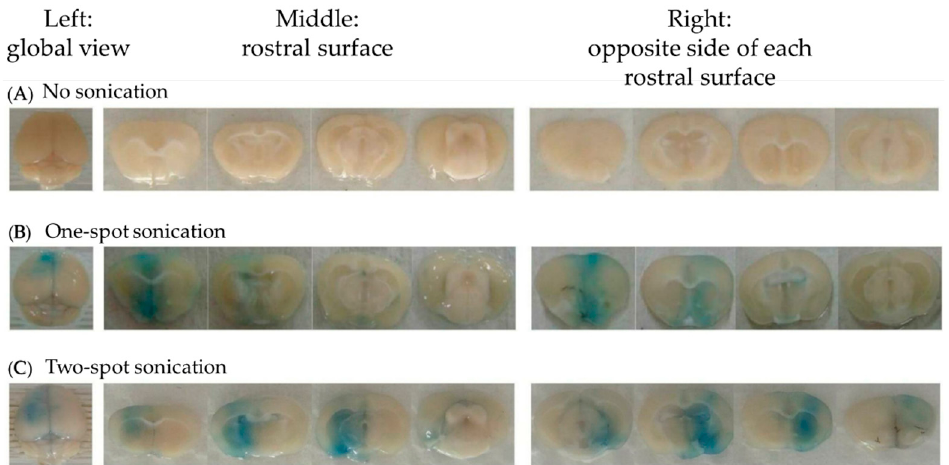
Figure 4. The rostral surface of four coronal sections from mice brain with BBBD induced by one- spot sonication and two-spot sonication in the sonication scheme study. Left: global view; middle: posterior side; right: anterior side. ( A ) EBD 100 mg/kg plus MB 150 µ L/kg injection only, no sonication. ( B ) One-spot sonication (EBD 100 mg/kg plus MB 150 µ L/kg). ( C ) Two-spot sonication (EBD 50 mg/kg plus MB 75 µ L/kg for each sonication). The stained area involved all slices. The left, middle, and right slices show the EBD distributed across the whole thickness of the treated side brain.